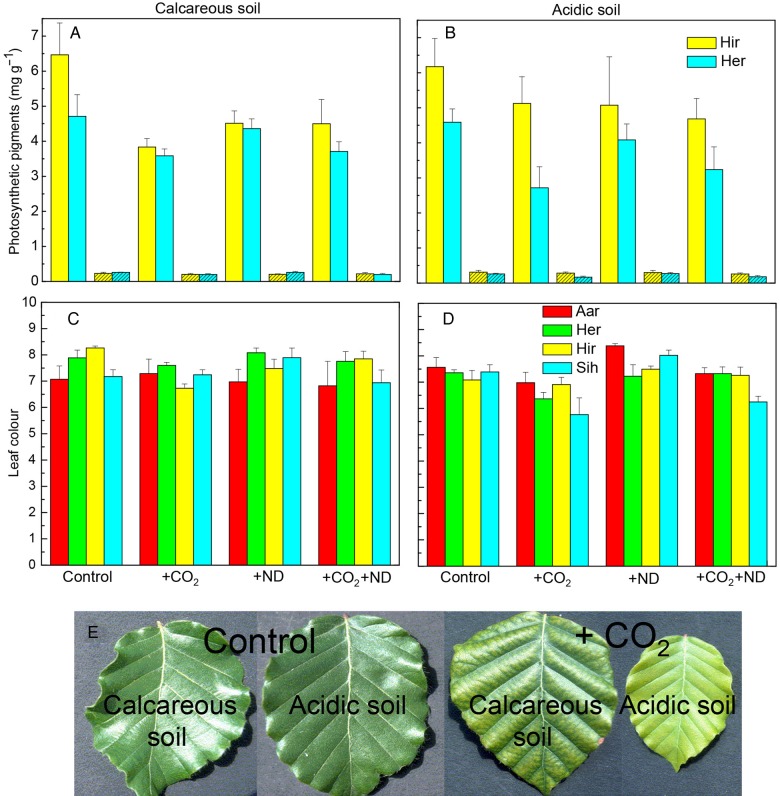
The change in the concentration of photosynthetic pigments in July (A and B), namely chlorophyll a + b and α + β carotenoids (hatched columns), and in the leaf colour in September (C and D) in response to +CO2, +ND and +CO2 + ND versus control, within the foliage of several origins of beech growing on either acidic or calcareous forest soil (mean values + SE, N = 4). Photographs (E) show typical examples of leaf discolouration in response to elevated CO2.